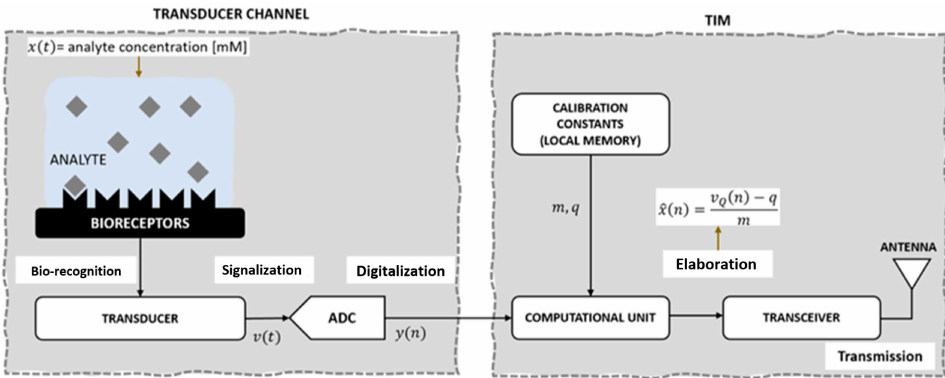
Figure 5. Functional diagram of a wearable